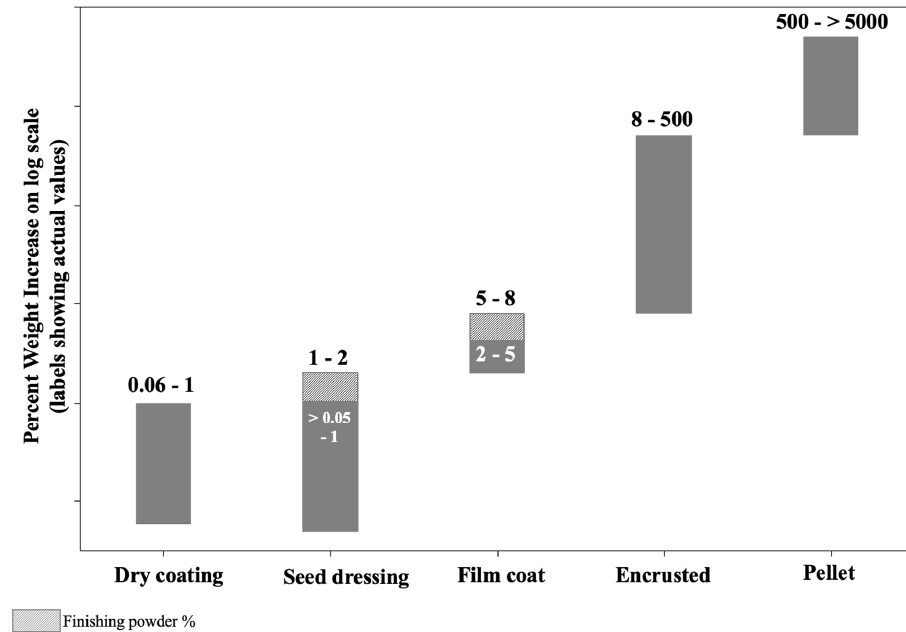
Figure 2. Percent weight increase after dry coating, seed dressing, film coat, entrustment and seed pellet technologies. The grey shaded bar for seed dressing and film coat is addition of a finishing powder during the coating process. The percent weight increase shown on a log scale to aid comparison between technologies.